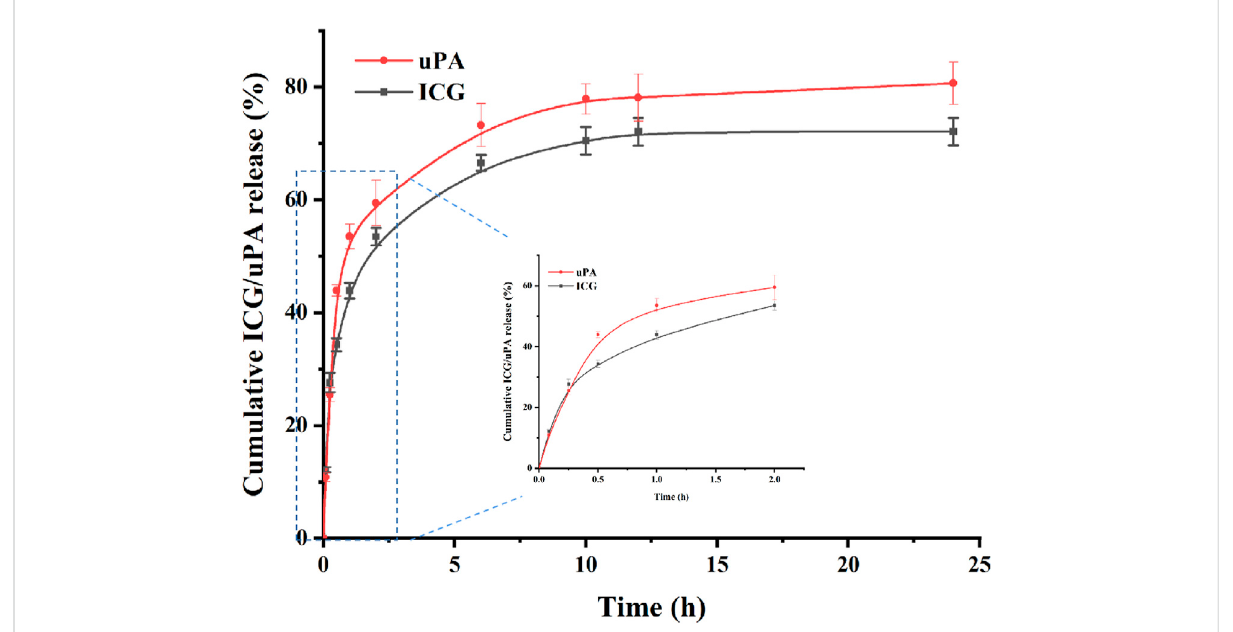
FIGURE 4 The release pro fi le of uPA and ICG from cRGD-ICG-uPA NPs in PBS, pH 7.4 ( n = 3).